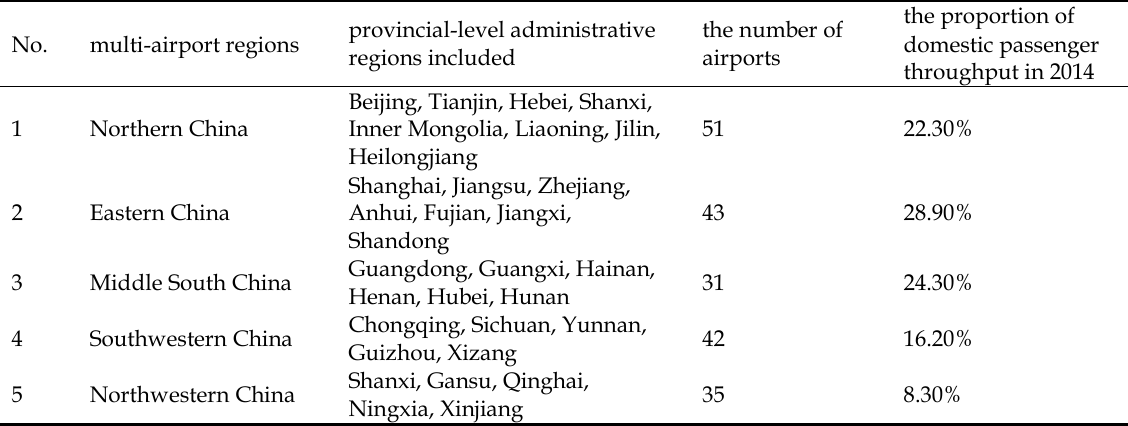
Multi-airport regions from